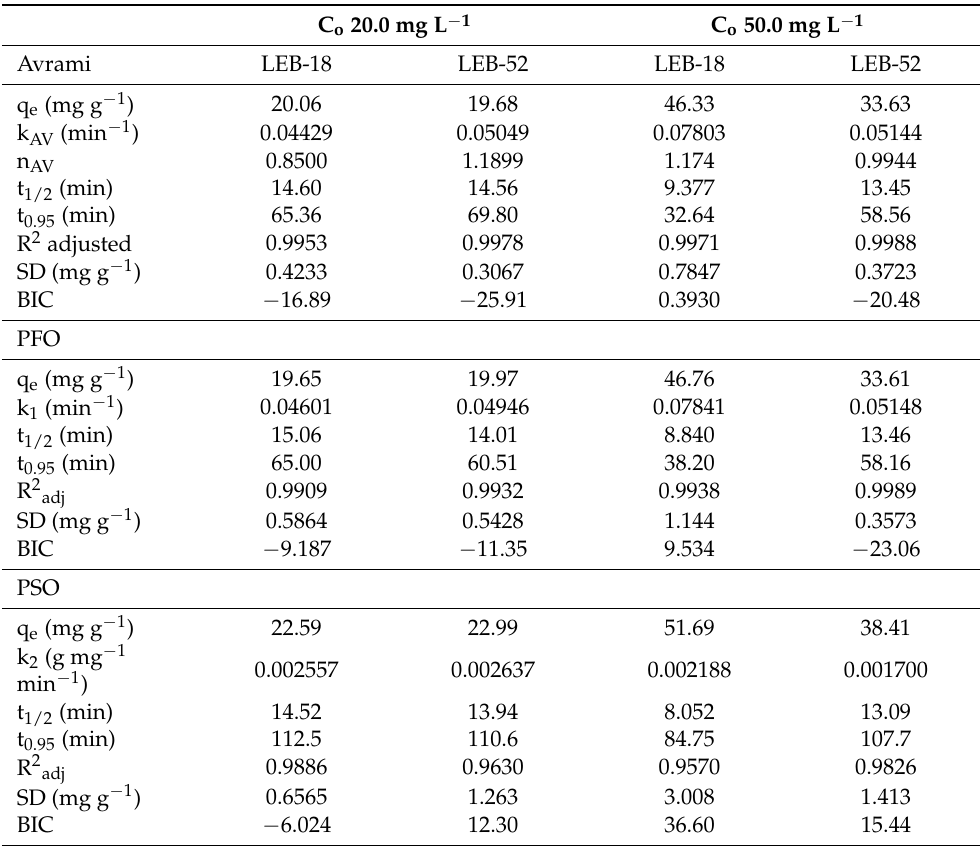
Table 3. Kinetic parameters for Nd(III) adsorption onto LEB-18 S. platensis and LEB-52 S. platensis